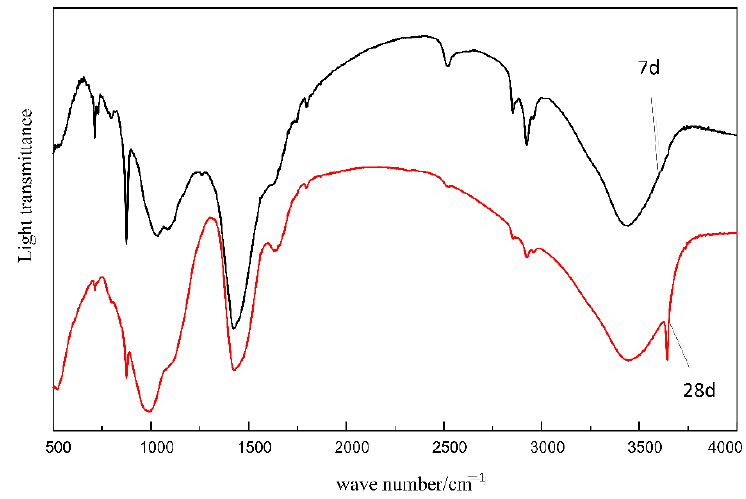
Figure 7. Infrared spectrum of slag/fly-ash-based geopolymer-stabilized macadam.